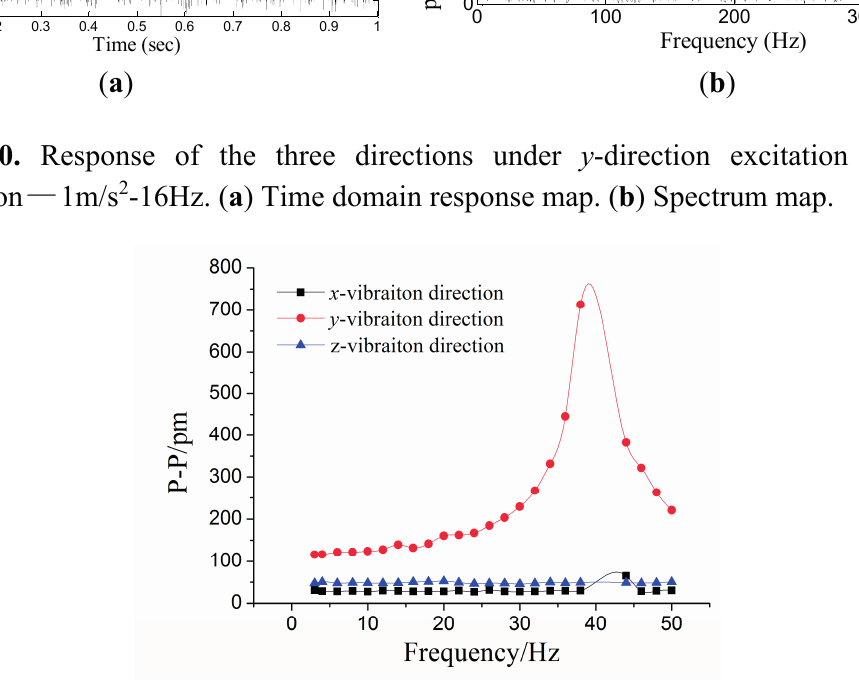
Figure 11. Amplitude-frequency curves of each direction under y -direction excitation